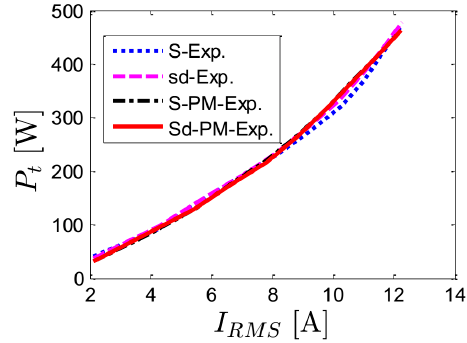
Figure 25. The measured losses of the four prototypes at optimal current angles and rated speed